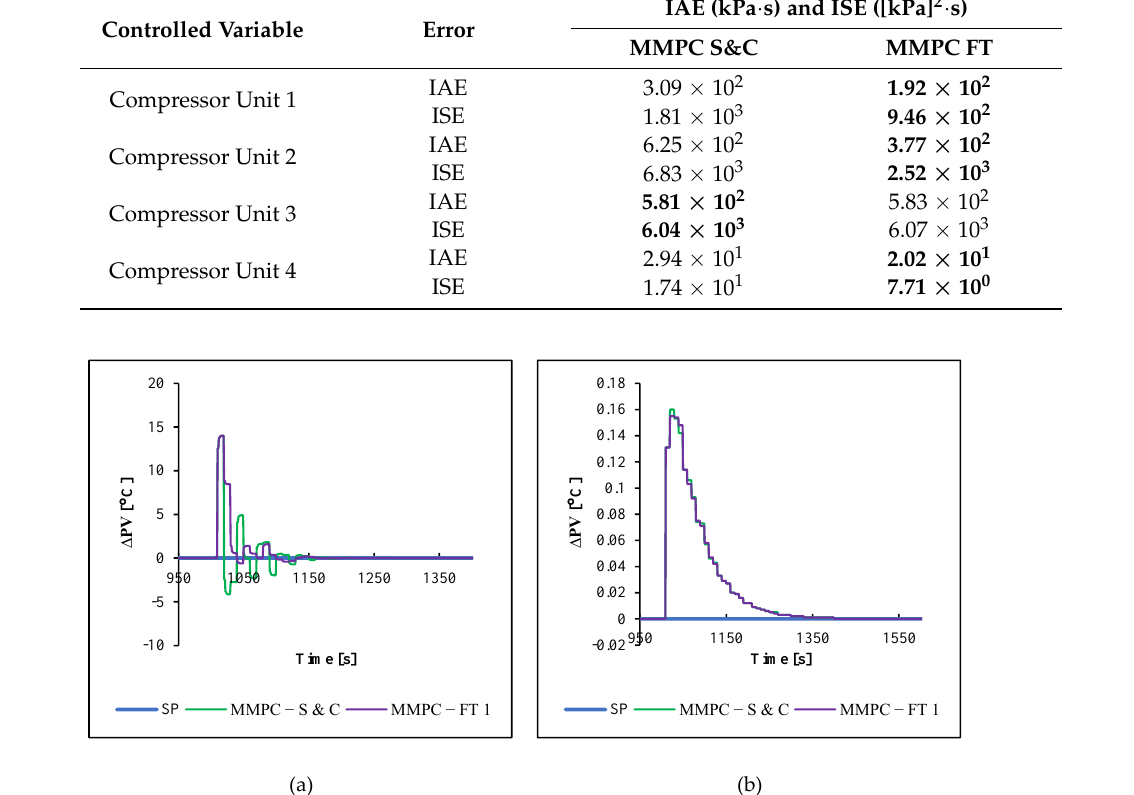
Table 19. Comparison of controller performance on the compressor unit (Disturbance Test).